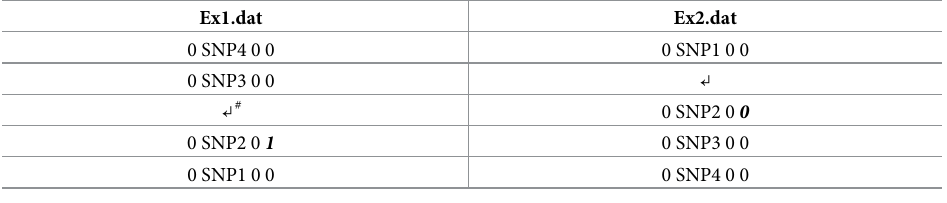
Table 3. Two sample